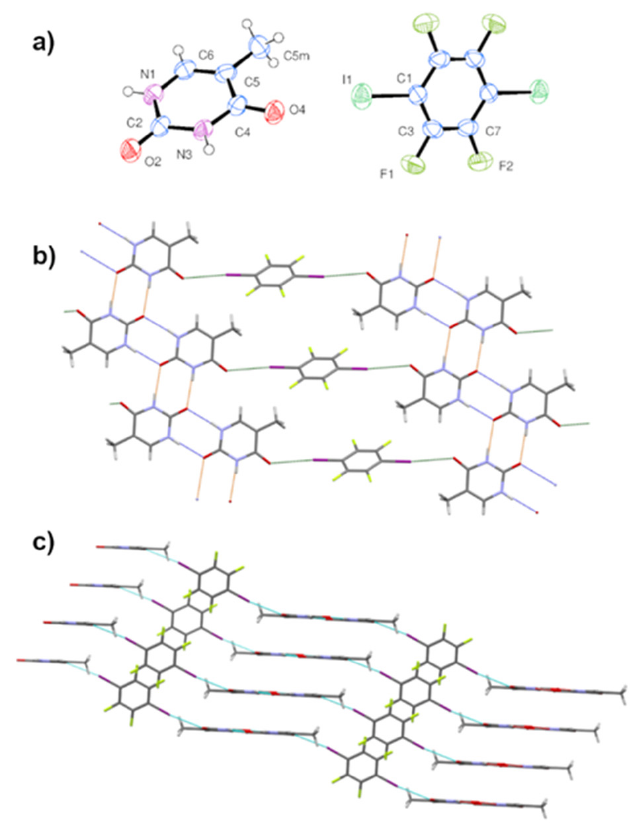
Int. J. Mol. Sci. 2021 , 22 , x FOR PEER REVIEW Figure 2. ( a ) ORTEP view of cocrystal 1 showing atom labeling. ( b ) 2D ladders formed by thymine– TFDIB molecules through H-bond and X-bond interactions. ( c ) 3D structure in cocrystal 1 .